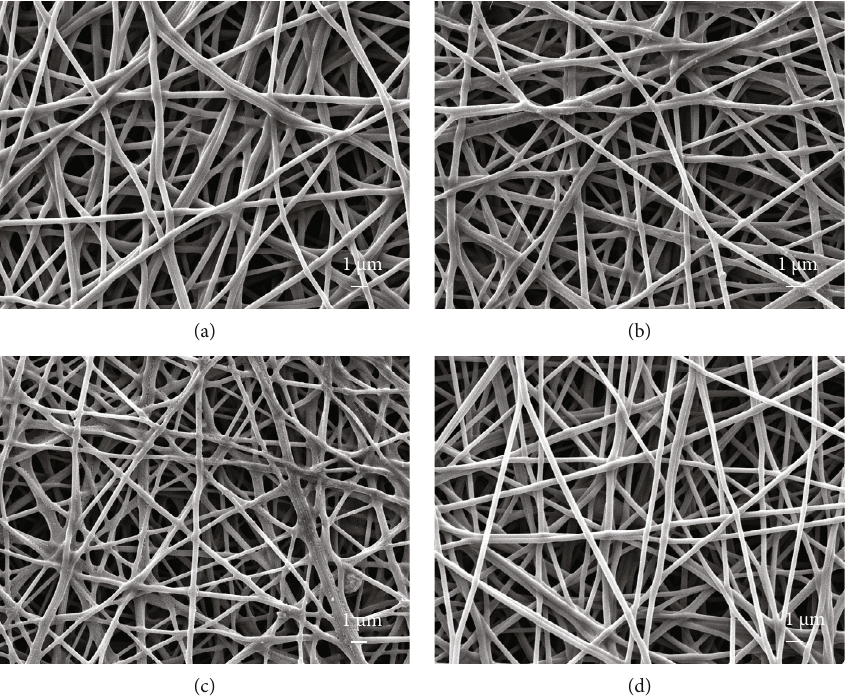
Figure 1: FE-SEM images of PVA/ZnO nano fi bers with di ff erent relative concentrations of ZnO NPs: (a) 0%, (b) 1%, (c) 4%, and (d)